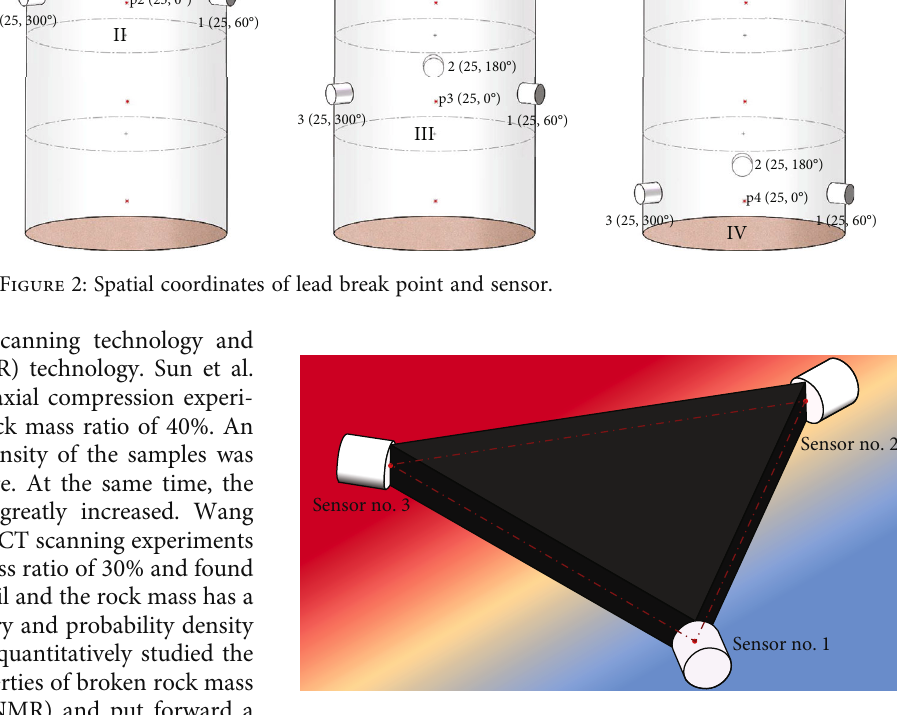
Figure 3: Equilateral triangle sensor array